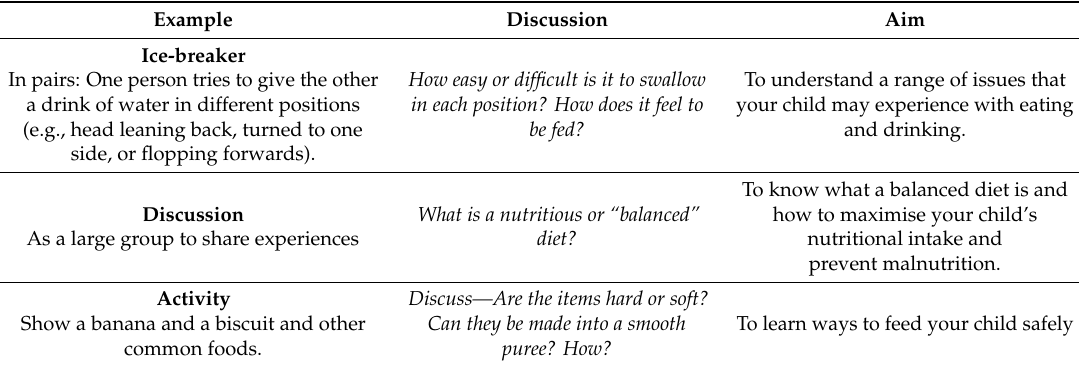
Table 3. Example of part of a facilitated group session on eating and